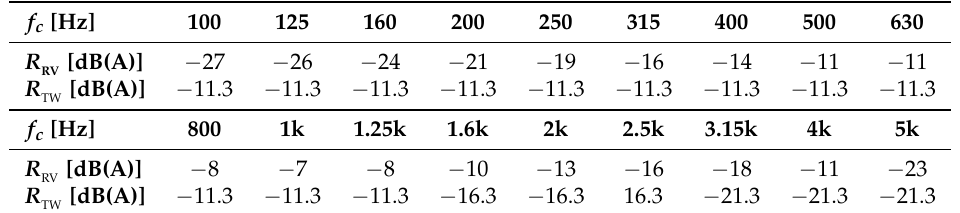
Table 1. Spectral distribution of the emission power R j RV (i.e., LV and HT) over non-porous surfaces and for TW at third octave bands of central frequencies f c (in Hz).